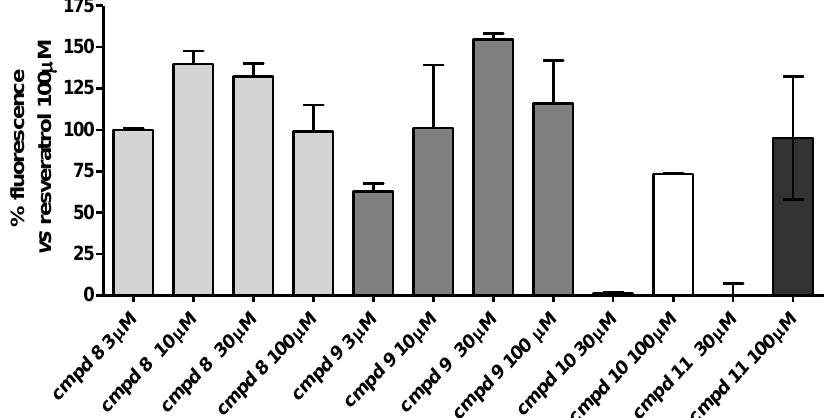
Figure 3. Concentration–response curve of the SIRT1 enzyme activation mediated by compounds 8 – 11 . The SIRT1 activity is expressed as % vs. the effect observed with 100 μM of resveratrol. The vertical bars symbolize the standard errors (n = 5).